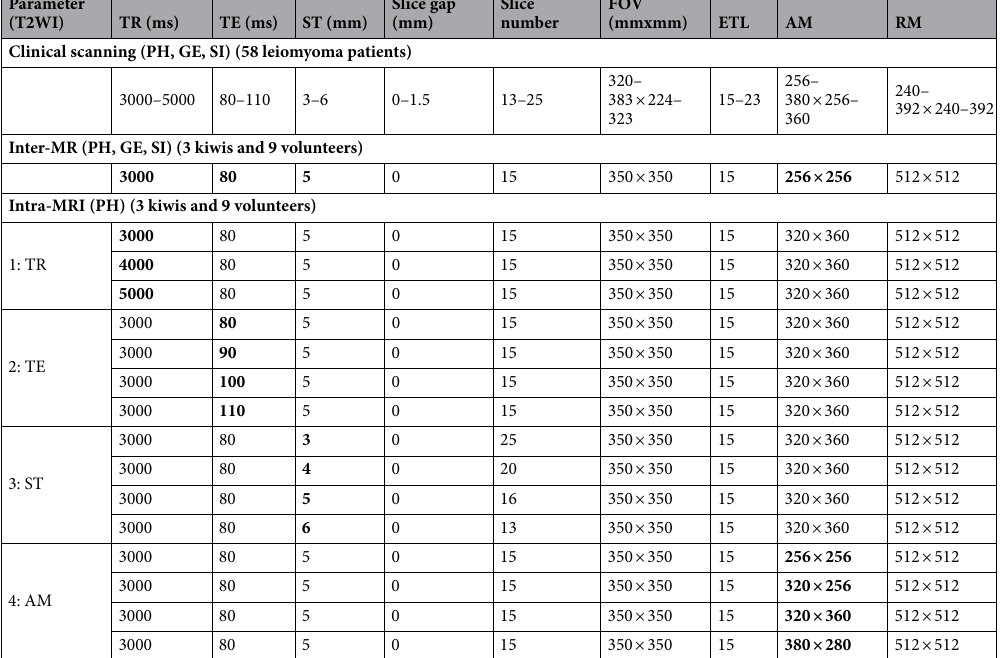
Table 3. MR scan acquisition parameters. TR repetition time; TE echo time; ST slice thickness; FOV field of view; ETL echo train length; AM acquisition matrix; RM reconstruction matrix; PH Philips Medical Systems; GE GE Medical Systems; SI Siemens Medical